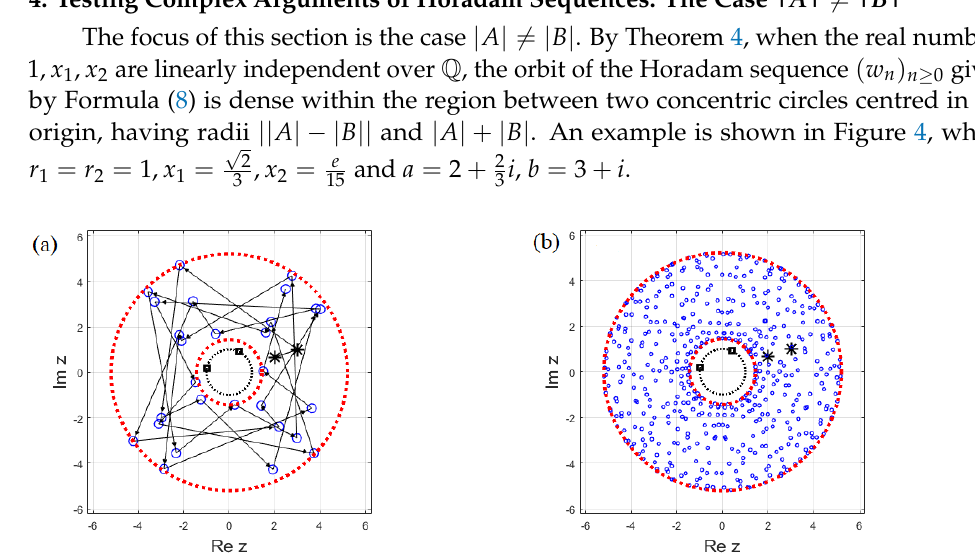
computed from Formula (1), n = 0